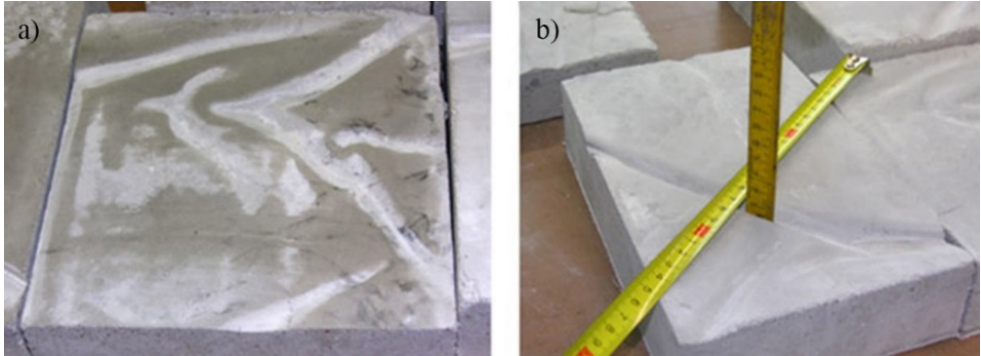
Figure 10. Example view: ( a ) the bottom surface of the floor, with grooved recesses constituting the “imprint” of the corrugated foil and ( b ) measuring the depth of the grooved cavities.